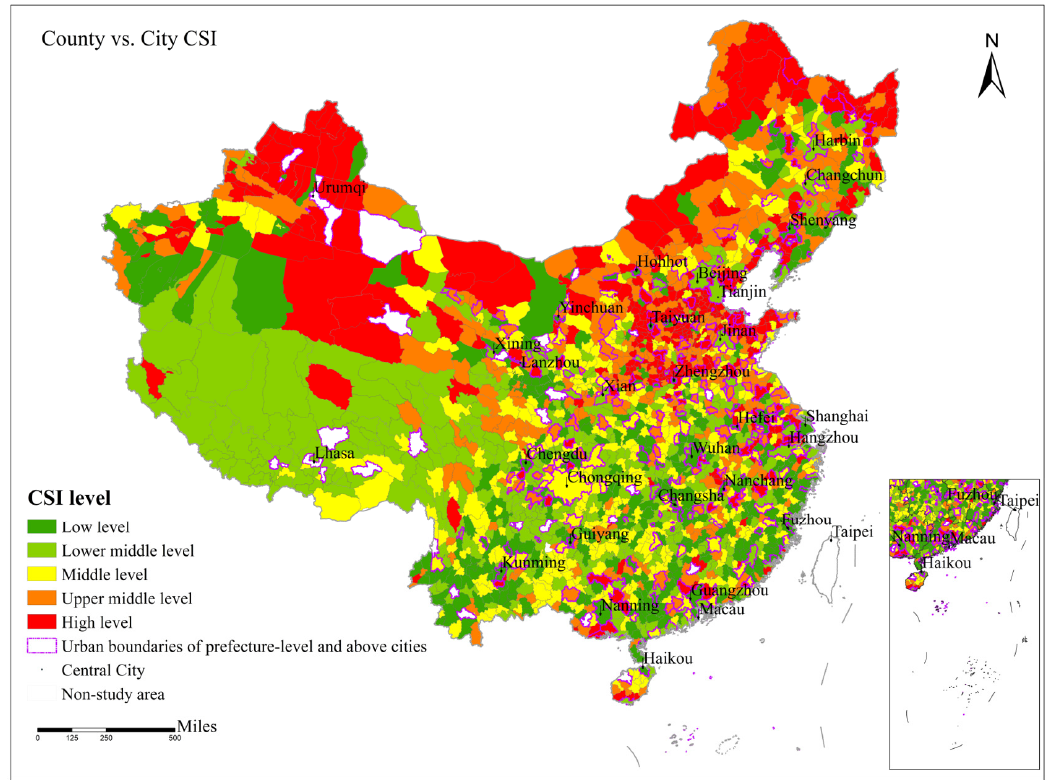
Figure 3. Spatial distribution pattern of county sprawl and municipal districts sprawl.